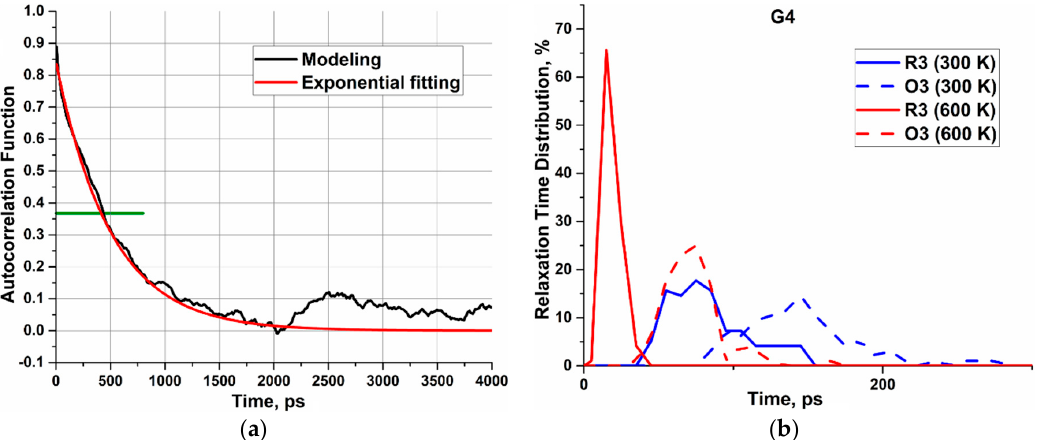
Figure 4. ( a ) The example of the angular autocorrelation function of one of the terminal groups of the